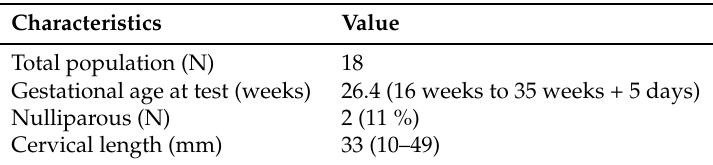
Figure 4. Normal quantile–quantile plots for the three velocity calculation procedures. Table 1. Features of the population in the